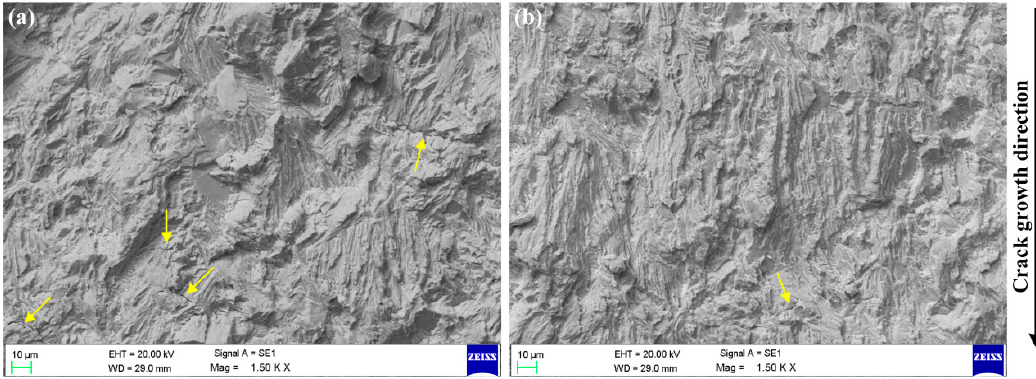
Figure 15. Fatigue fracture surface morphologies at a < 1 mm: ( a ) LD1 specimen; ( b ) TD1 specimen.